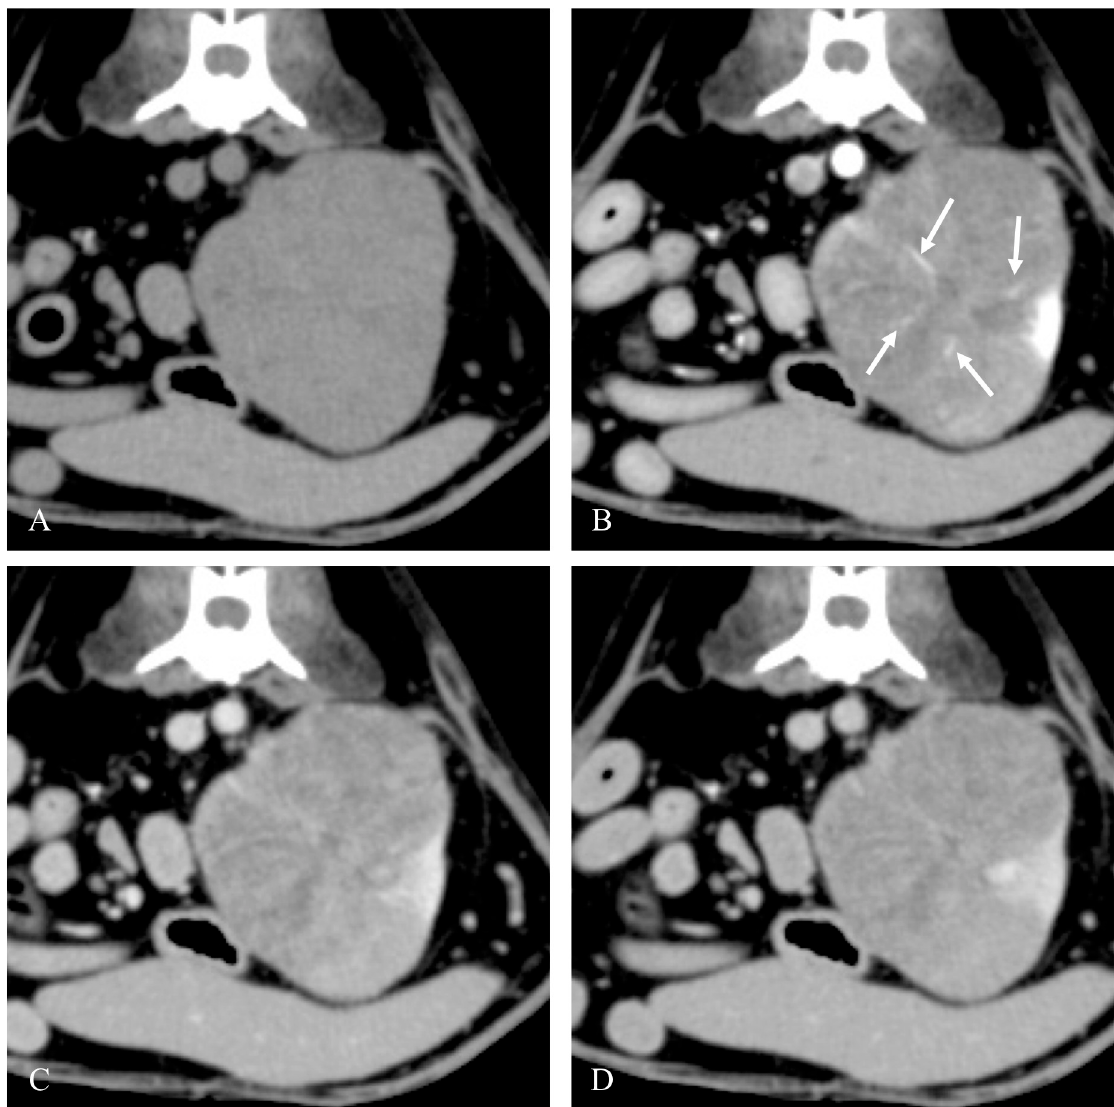
Fig 2. Representative axial pre-contrast (A) CT image of an RCC and post-contrast corticomedullary (B), nephrographic (C), and excretory (D) phase CT images of the RCC. The tumor had unilateral involvement and showed heterogeneous enhancement. Vessel enhancement (arrow) was detected in the post-contrast corticomedullary phase only. Abbreviations: CT, computed tomography; RCC, renal cell